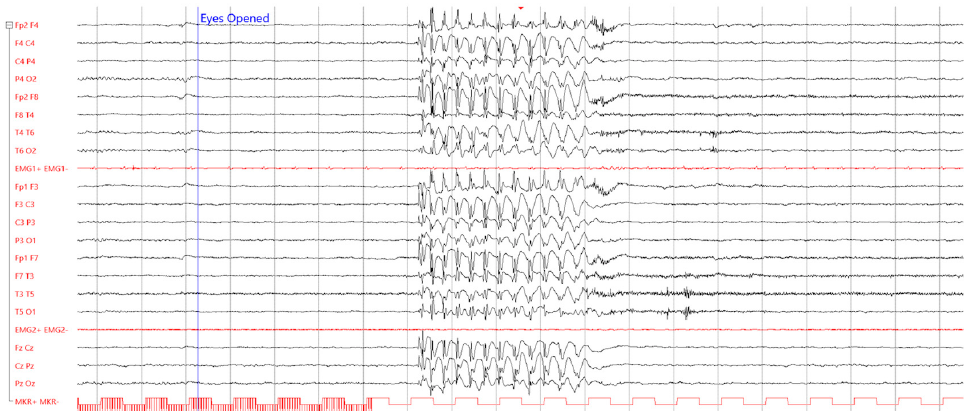
Figure 4. Example of comorbidity between young-onset diabetes mellitus and idiopathic generalized epilepsy. EEG recording (10–20 International System) of a 10-year-old boy affected by MODY (inherited CGK mutation) referred for recurrent episodes of unresponsiveness. The exam displays diffuse rhythmic 3.5 Hz spike-and-wave discharges, compatible with childhood absence